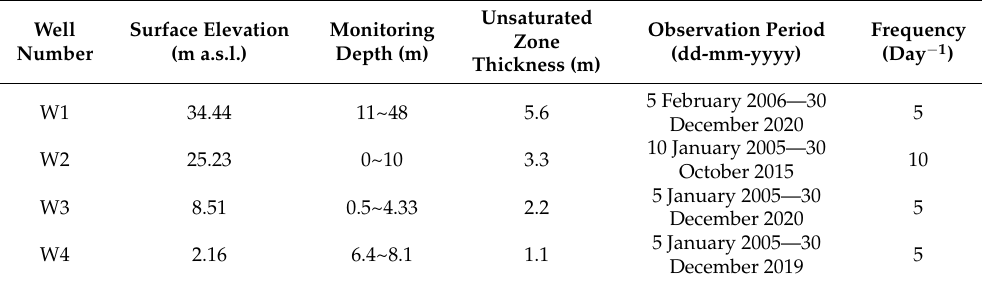
Table 1. Detail information of the monitoring wells. The thickness of unsaturated zones was calculated as the average depth over the observation period. Well Surface Elevation Monitoring Number (m a.s.l.) Depth